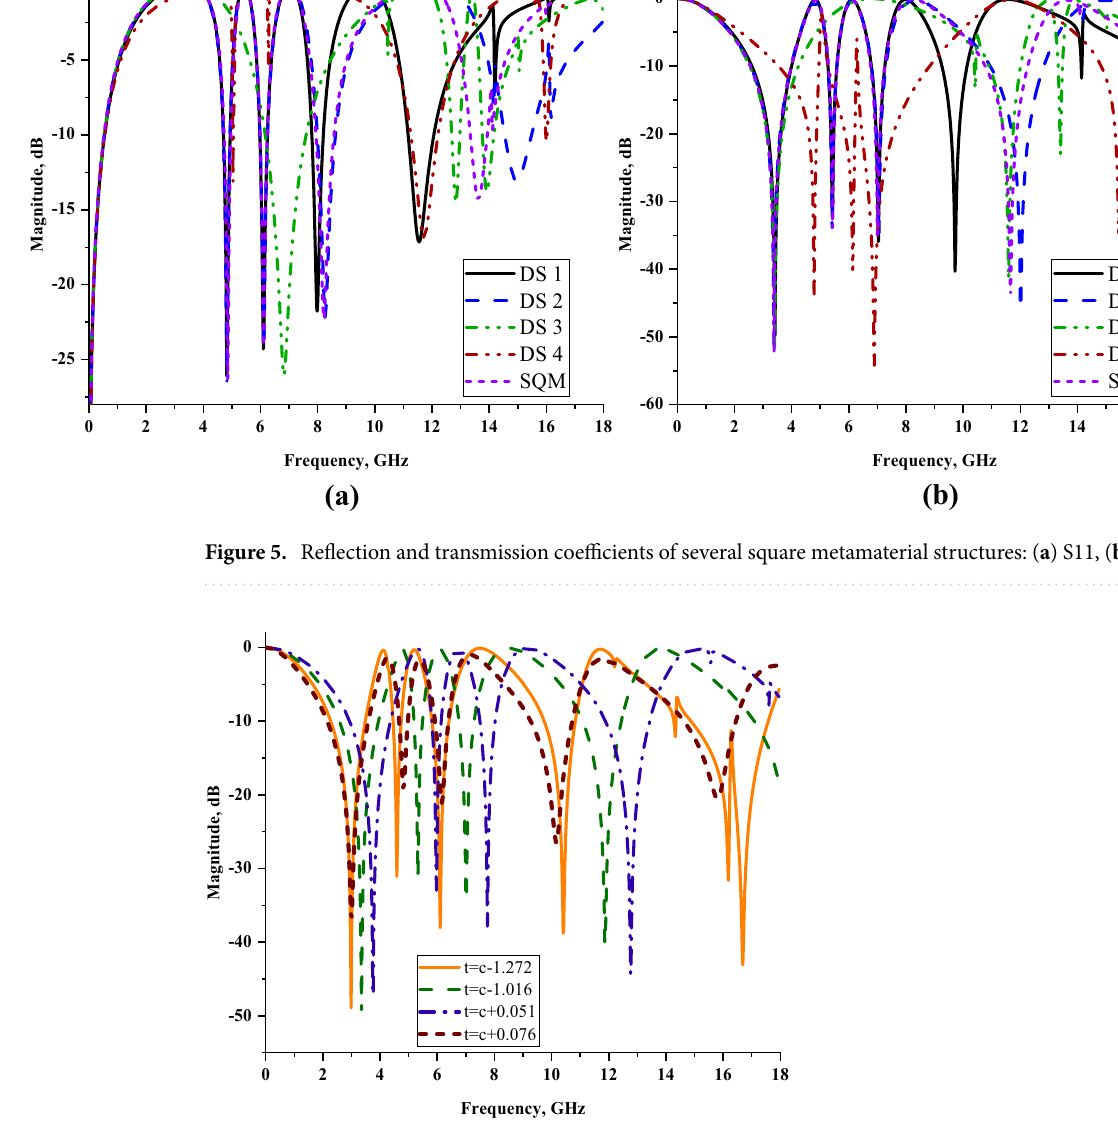
Figure 6. Transmission coefficients (S21) of several substrate materials utilising similar SQM